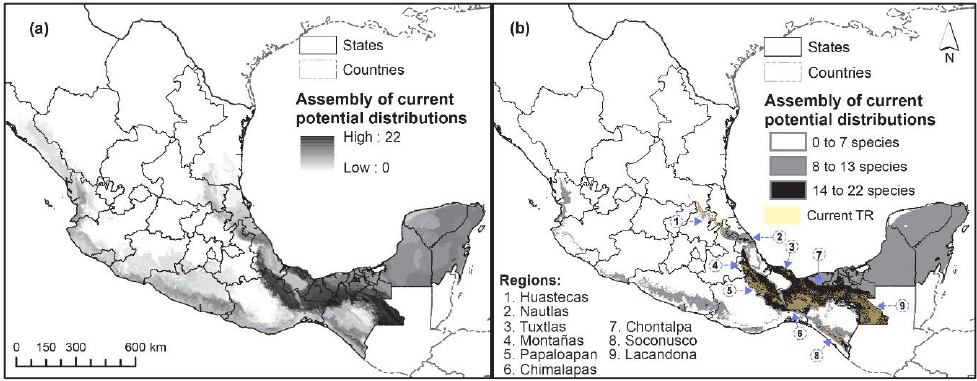
Figure 4. Current potential distributions for the 22 tropical rainforest species considered in this study. ( a ) Assembly map; ( b ) assembly map with three classes.